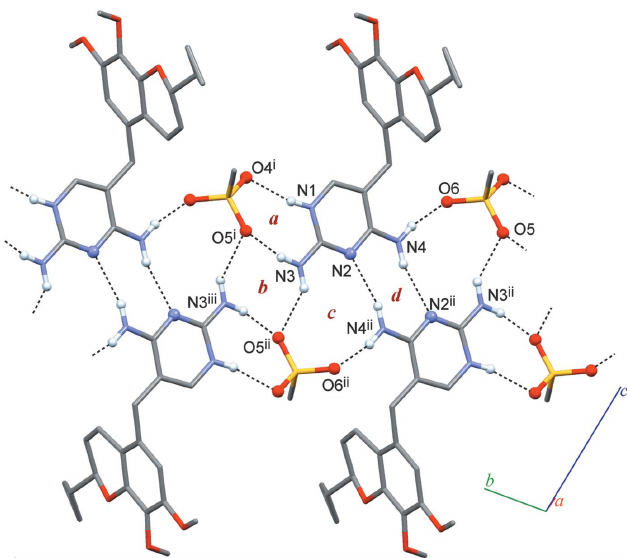
Figure 2 Tape structure composed of N—H (cid:2)(cid:2)(cid:2) O and N—H (cid:2)(cid:2)(cid:2) N-bonded iclaprim and mesylate molecules, based on four essential ring motifs ( a – d ). [Symmetry codes: (i) x (cid:3) 1, y + 1, z ; (ii) (cid:3) x , (cid:3) y + 1, (cid:3) z ; (iii) (cid:3) x (cid:3) 1, y + 2, z .]